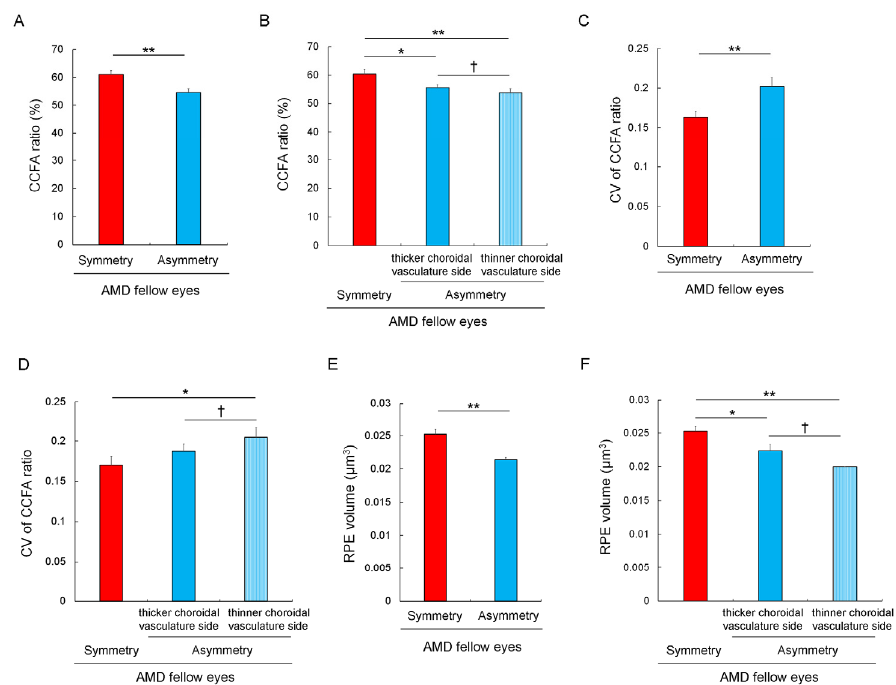
Figure 2. Choriocapillaris flow area (CCFA) ratio of age-related macular degeneration (AMD) in fellow eyes with or without fundus autofluorescence (FAF) abnormalities. In AMD fellow eyes, the CCFA ratio was lower in eyes with FAF abnormalities than in those without, and in AMD fellow eyes with FAF abnormalities, the CCFA ratio was lower in the FAF abnormal area than in the FAF normal area. * p < 0.05, ** p < 0.01, Mann–Whitney U test. † p < 0.01, Wilcoxon signed-rank test.